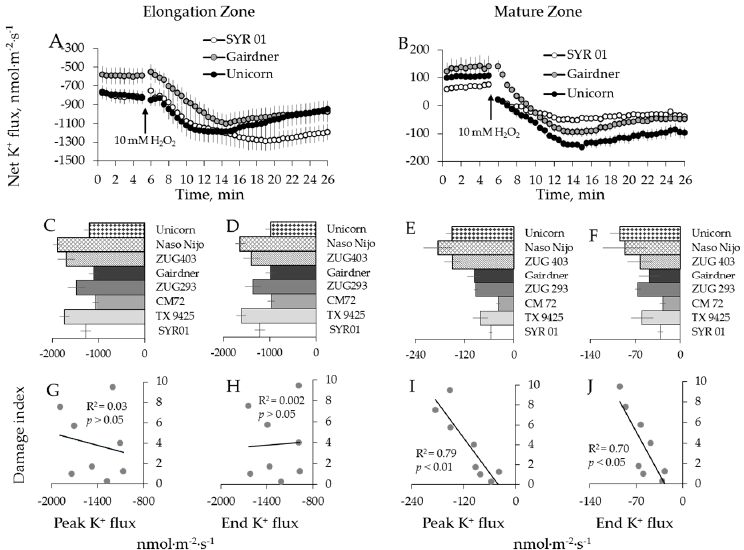
Figure 4. Kinetics of K + fluxes from three representative barley varieties in response to 10 mM H 2 O 2 treatment from both root elongation zone ( A ) and mature zone ( B ). Error bars are means ± SE ( n = 6–8). ( C , D , G , H ) Peak ( C ) and end ( D ) K + fluxes of eight barley varieties in response to 10 mM H 2 O 2 and their correlation with damage index ( G , H , respectively) in root elongation zone. ( E , F , I , J ) Peak ( E ) and end ( F ) K + fluxes of eight barley varieties in response to 10 mM H 2 O 2 and their correlation with damage index ( I , J , respectively) in root mature zone.